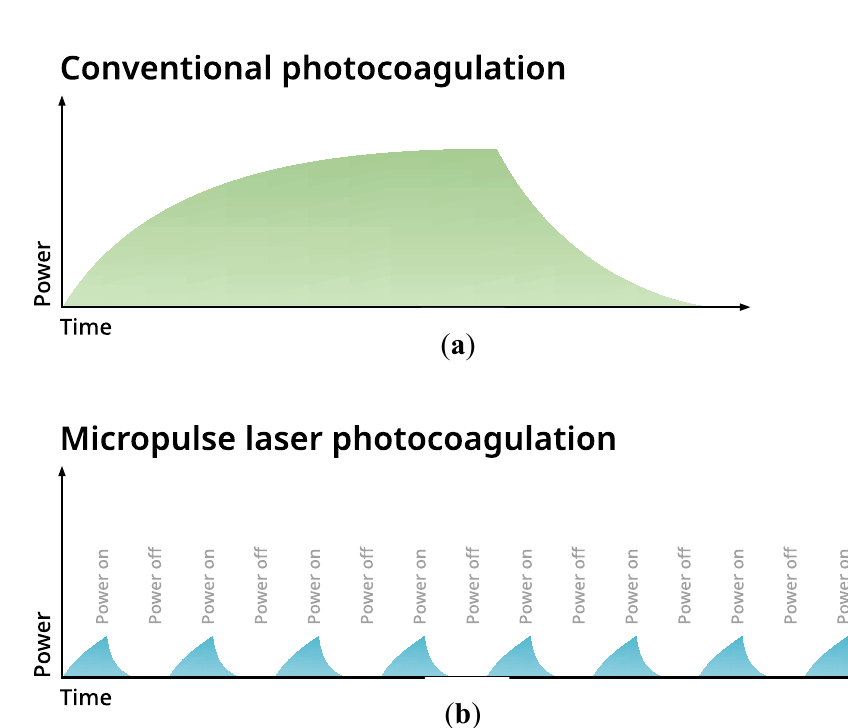
Figure 1. ( a , b ) Mechanism of action of continuous wave laser versus subthreshold micropulse laser treatment (SMPLT). ( a ) In application of continous wave laser the power is distributed evenly within the duration of an impact. ( b ) In SMPLT, laser impact is delivered in a train of short impulses between which there are intervals that enable retinal tissue to cool down.